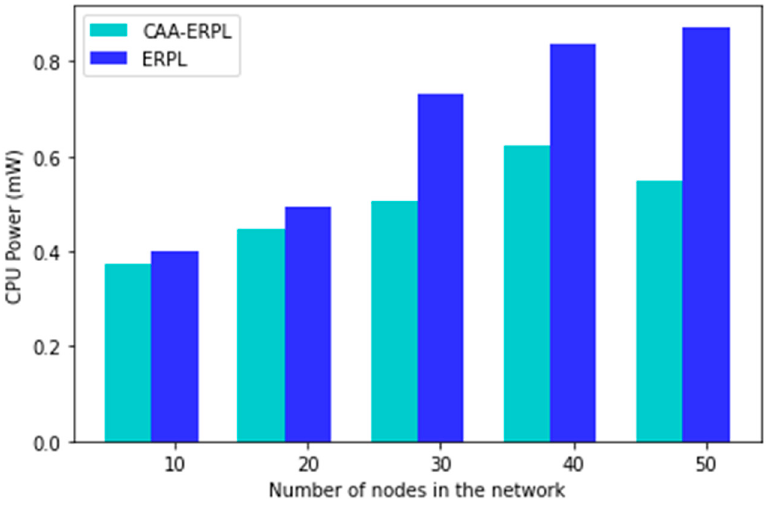
Figure 10. CPU utilization vs. scalability of the network.